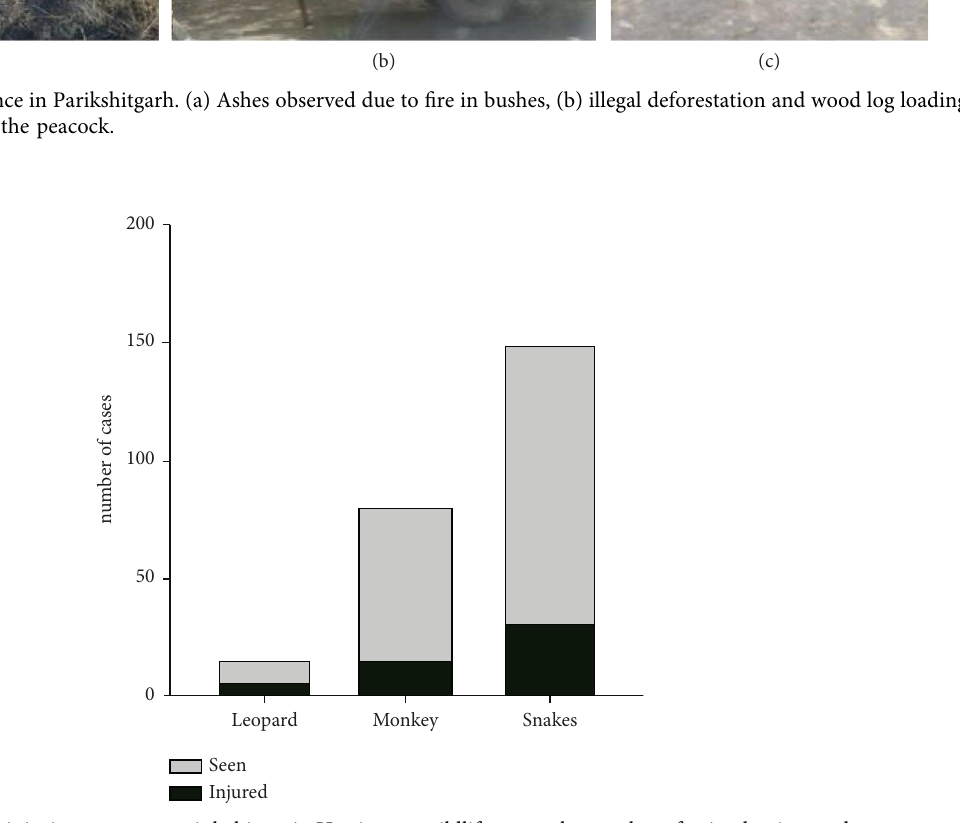
Figure 6: Animals inficting injuries to sanctuary inhabitant in Hastinapur wildlife area—the number of animals witnessed as compared to injury caused by